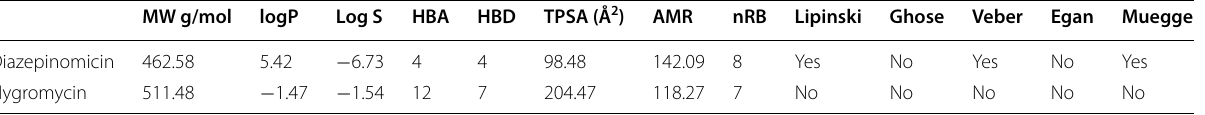
HBA Num. H-bond acceptors, HBD Num. H-bond donors, nRB Num. rotatable bonds, AMR atom molar